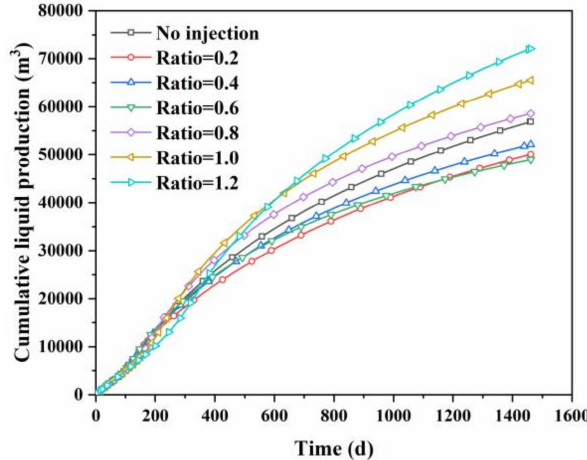
Figure 17. Cumulative liquid production of infill well.